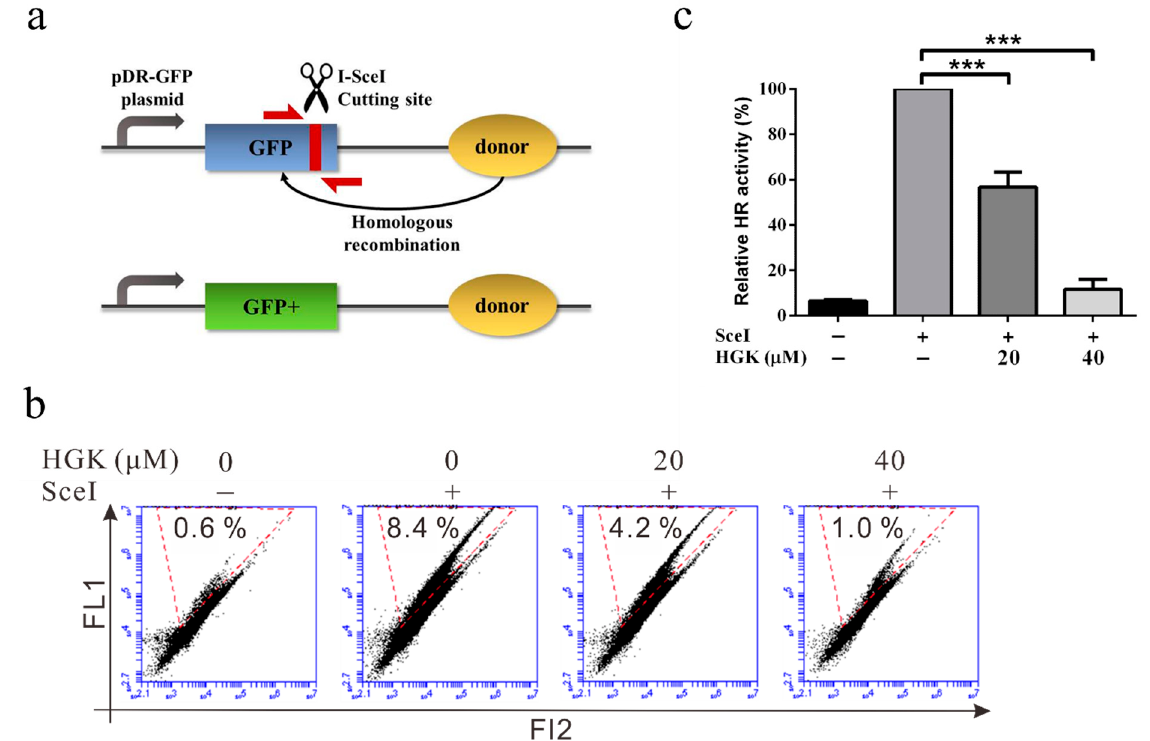
Figure 3. Hydroxygenkwanin (HGK) inhibits homologous recombination (HR) repair in hepatocellular carcinoma cell lines. ( a ) Schematic representation of the I-SceI-based HR assay. DR-GFP plasmid contains a truncated GFP-coding region that contains an I-SceI cutting site (blue). The I-SceI cleavage site can be repaired by HR using the downstream GFP donor template (yellow), resulting in GFP-positive cells (green). ( b ) Representative flow cytometry plots show the effect of HGK on HR activity in Huh7 cells. Huh7 cells were co-transfected with the DR-GFP vector and I-SceI expression vector with or without HGK treatment for 48 h to measure the HR-mediated repair capacity. The GFP-positive cells (area marked with red dashed line) were then detected by flow cytometry. FL1: green fluorescence; FL2: orange fluorescence. ( c ) Quantitative results for HR activity. p < 0.001 (***).